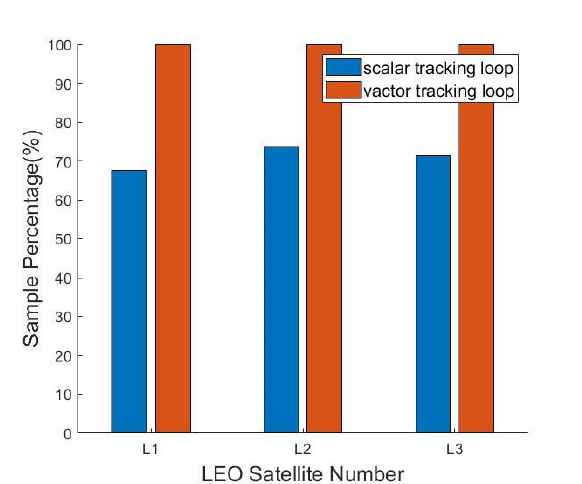
Figure 6 . Comparison of the sample percentage within the frequency error bounds between VTL and STL